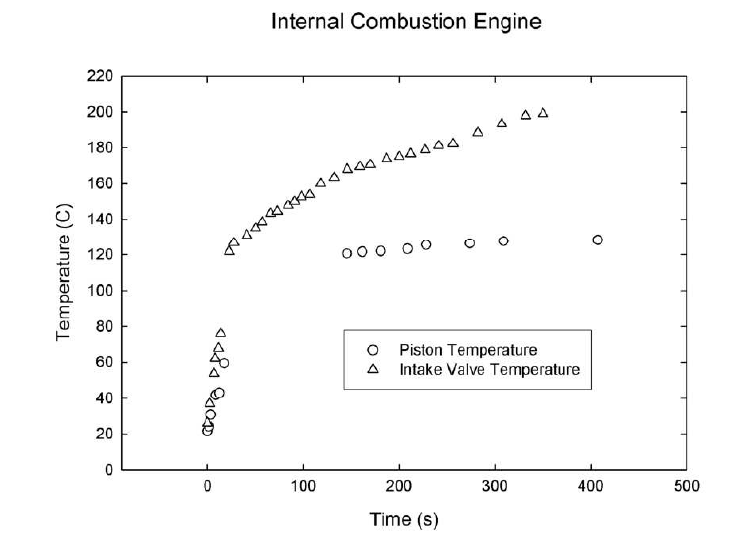
Figure 55. Results for piston and intake value experiments